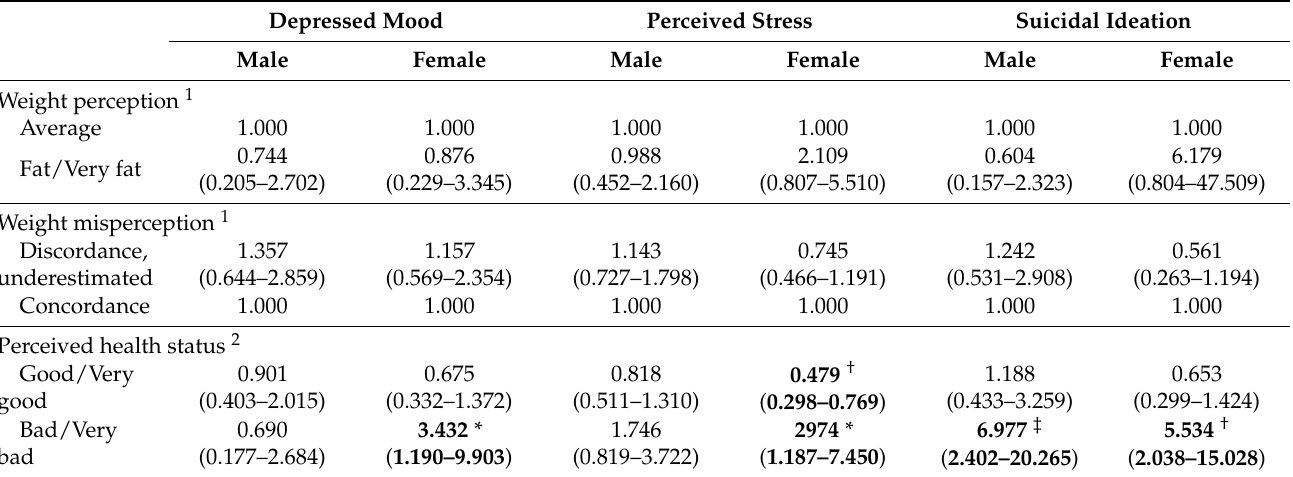
Table 3. Associations between weight status and mental health of overweight and obese